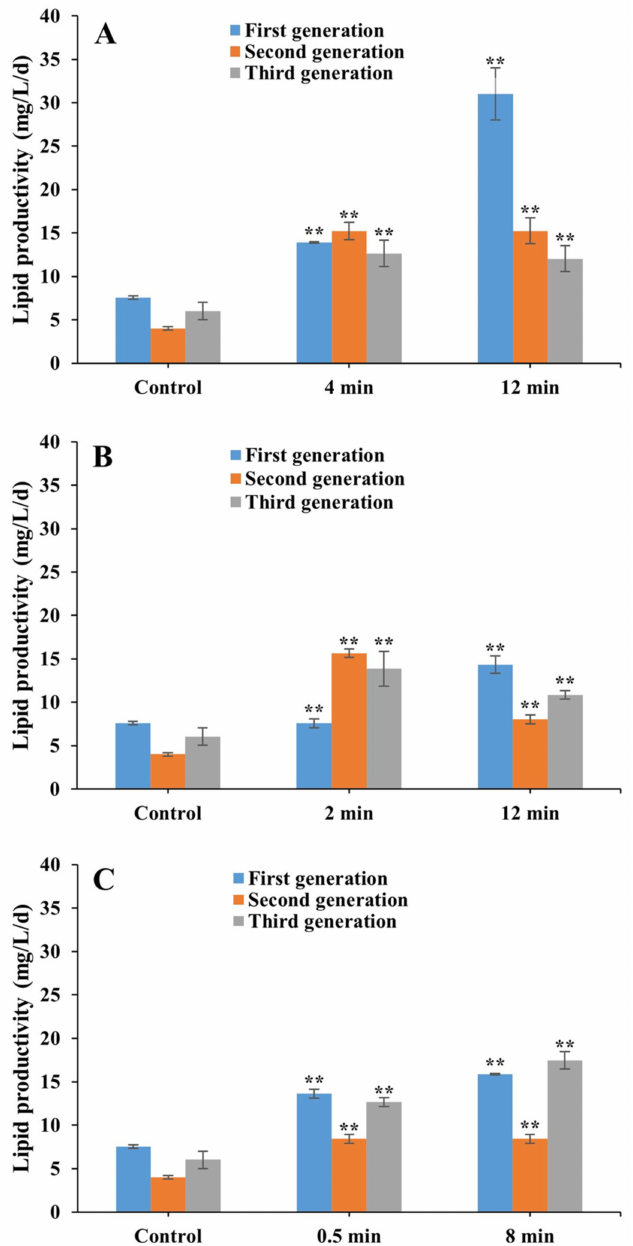
Figure 9. Lipid productivity of laser mutants of Chlorella pyrenoidesa strain FACHB 31 treated with He–Ne ( A ), Nd:YAG ( B ), and SC ( C ) cultured under heterotrophic cultivation for 21 days (three generations). Data are presented as mean ± standard errors ( n = 3). Symbol “**” indicates statistically significant differences compared to controls at p <